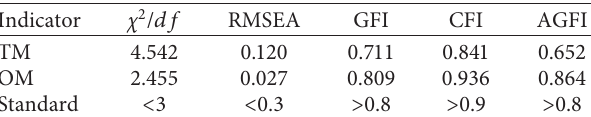
Table 5: Actual test values and standard values of model fitness indexes.